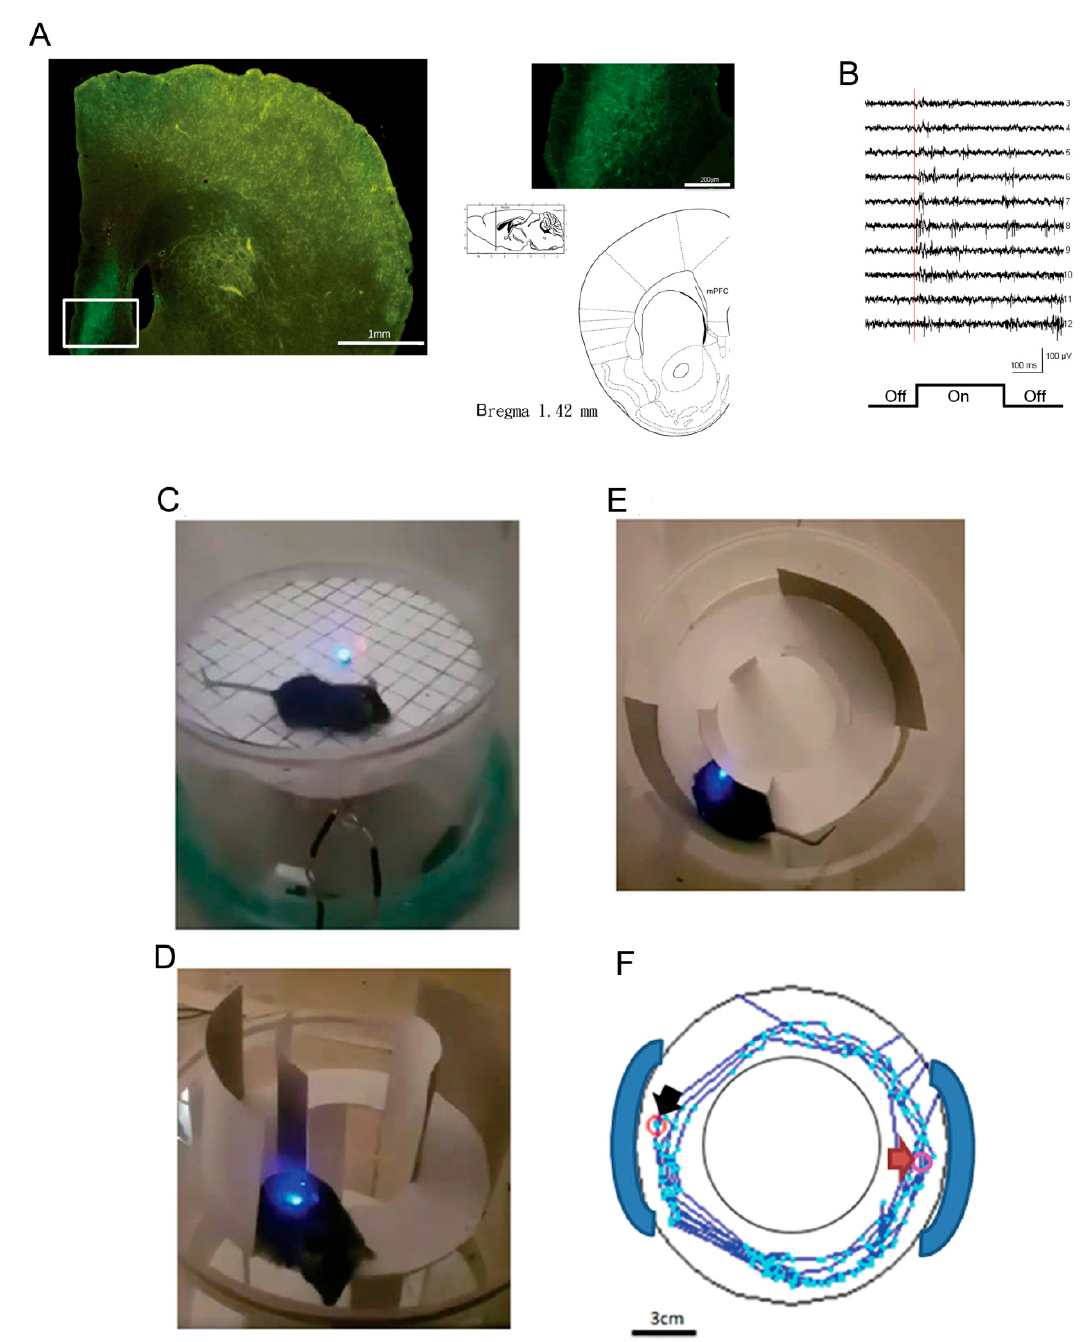
Figure 6. Anxiety behavior tests in the zero-maze and open-field tasks with optogenetic photostimulation. ( A ) The ChR2 transfection in the medial prefrontal cortex (mPFC). Left: The whole view of the brain section. Right: The enlarged portion of the square on the left and the atlas show the relative section in sagittal and coronal views, + 1.42 mm rostral to bregma. ( B ). An example of multichannel neuronal unit activity recording in the mPFC. The marker indicated the turning on of the optogentic stimulation. ( C – E ) These pictures depict testing anxiety behavior in the zero-maze task; the optical fiber is implanted into the mPFC. ( F ) Using an auto-tracking device, the animal’s path was drawn using photostimulations into the mPFC in the zero-maze task. The black arrow represents the starting point and the red arrow represents the ending point.